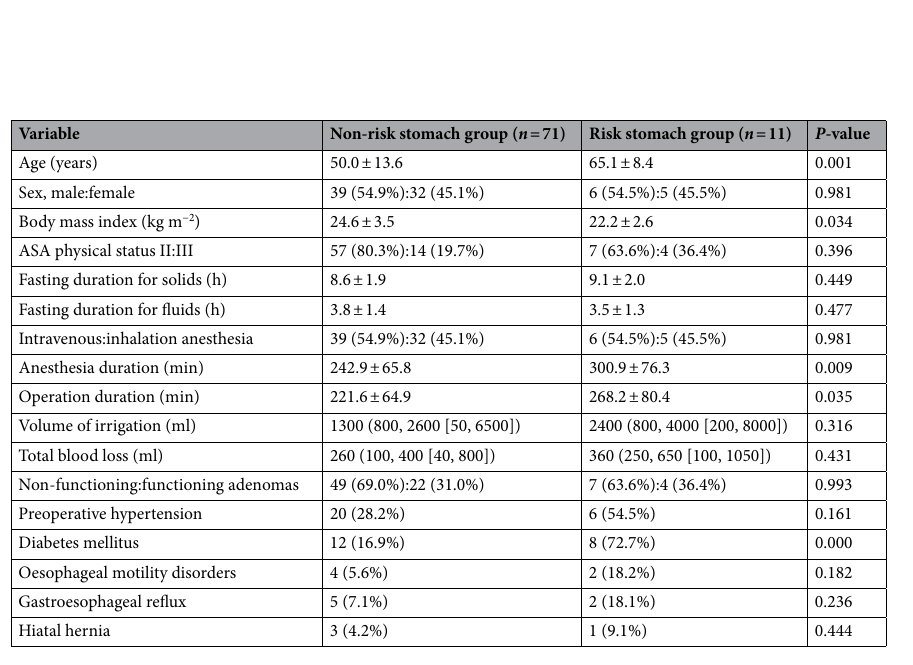
Table 3. The baseline characteristics and surgical variables of patients with postoperative risk stomach and non-risk stomach. Values are presented as mean ± SD, median (interquartile [range]) or n (%).